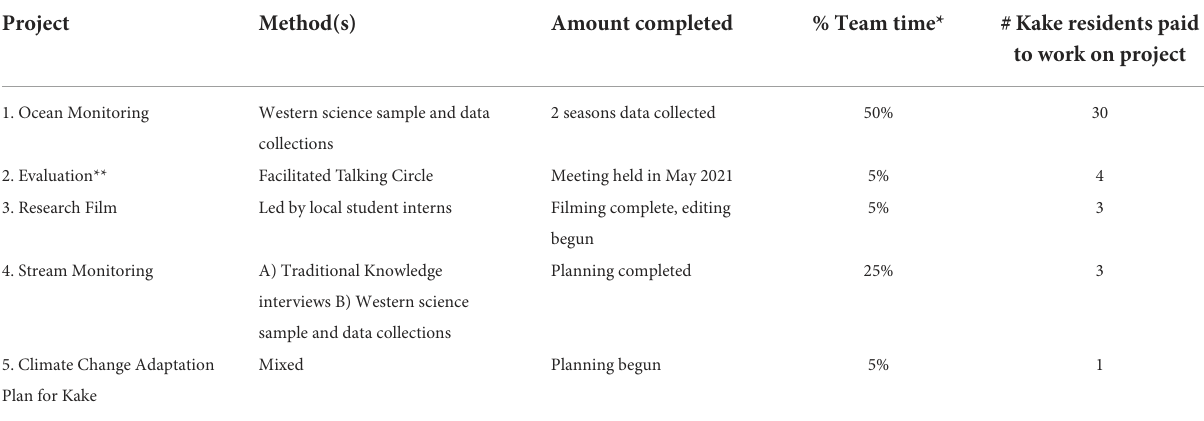
TABLE 4 Field projects in order of priority and